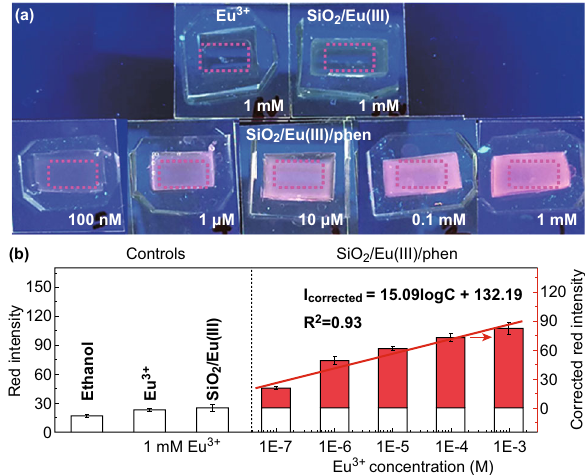
Fig. 4 a A digital photograph of various solution samples under an UV lamp with a wavelength of 302 nm. Each sample represents 400 uL ethanolic solution (or dispersion) of the corresponding nanopar- ticles confined in PDMS pockets. The samples in the top row are 1 mM EuCl 3 solution and SiO 2 /Eu(III) nanoparticle dispersion with Eu 3 ? ions adsorbed from 1 mM EuCl 3 solution. The bottom row shows the SiO 2 /Eu(III)/phen nanoparticle dispersions Eu 3 ? ions adsorbed from EuCl 3 solutions with concentrations from 100 nM to 1 mM (from left to right). b Quantized red emission intensities of various samples shown in a . (Color figure